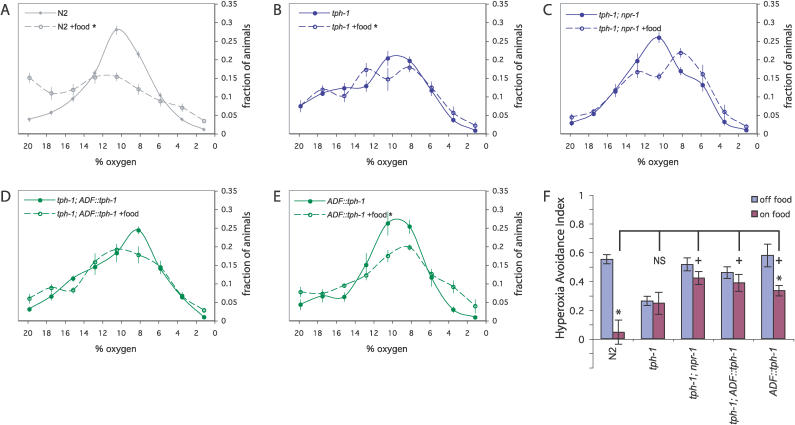
Levels of Serotonin in ADF Neurons Affect Food Regulation of Hyperoxia Avoidance(A–E) In all panels, dotted lines indicate aerotaxis in the presence of a small amount of bacterial food. (A) Aerotaxis of wild-type N2 animals. (B) Aerotaxis of tph-1 mutants. (C) Aerotaxis of tph-1; npr-1 double mutants. (D) Aerotaxis of tph-1 animals rescued in ADF with a srh-142::tph-1::gfp transgene [28]. (E) Aerotaxis of wild-type animals expressing tph-1 in ADF from a srh-142::tph-1::gfp transgene. For (A–E), asterisks denote distributions different by chi-square analysis at p < 0.01 from the same genotype without food. n ≥ 3 assays per genotype and condition, 80–100 animals/assay. Error bars denote SEM. (F) Hyperoxia avoidance index as defined in Figure 1. Asterisks, values significantly different from the same genotype without food at p < 0.05 by t test. Crosses, values significantly different from N2 on food at p < 0.01 by Dunnett test. NS, not significant. Error bars denote SEM.